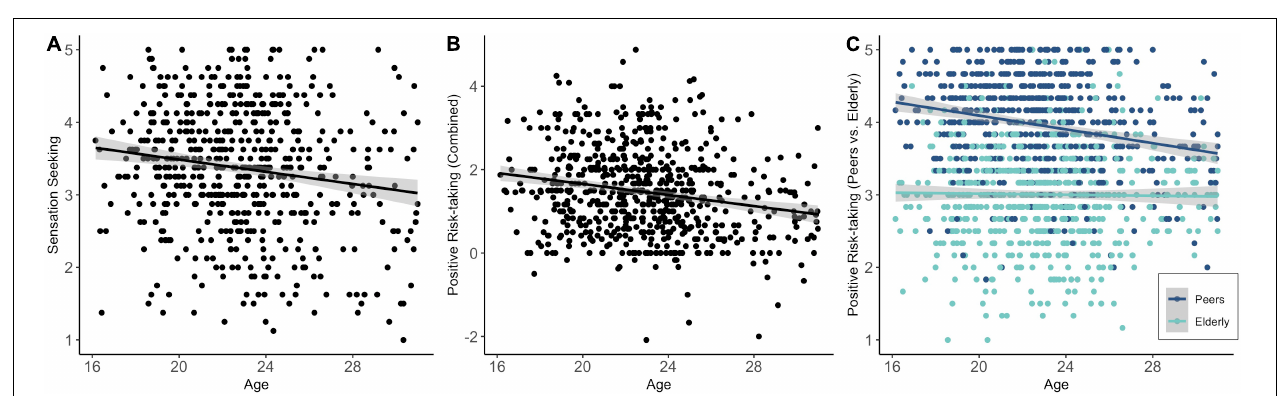
FIGURE 3 | Linear age effects on sensation seeking (A) , general positive risk-taking (B) , and positive risk-taking to peers versus elderly (i.e., non-adherence to social distancing and contract restriction), with larger differences between peers and elderly being indicative of higher positive risk-taking (C).